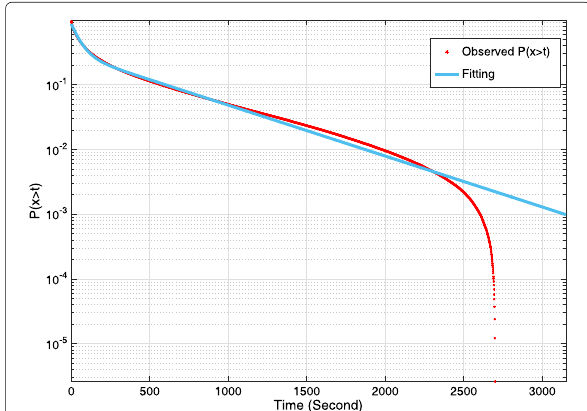
Fig. 9 Sailing alone time distribution